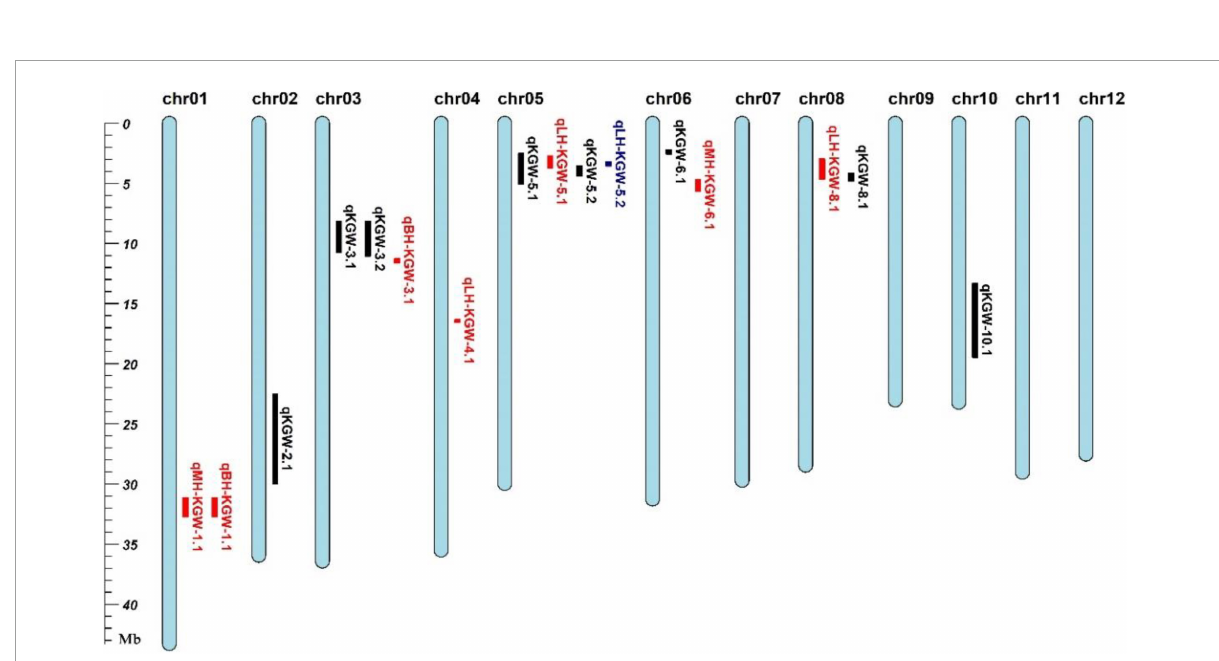
FIGURE6 Grain weight heterosis loci in two testcross populations. Black represents QTL loci in recombinant inbred lines (RILs). Red and blue loci represent heterosis-related QTLs of YTA and Z7A testcross population,